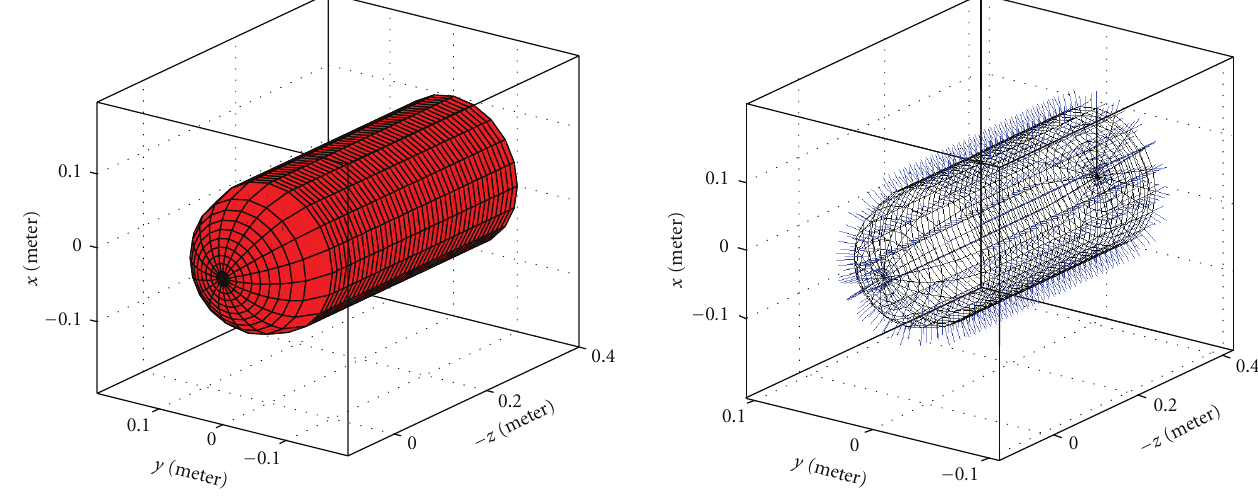
Figure 2: Computer-generated three-dimensional model of the shell-shaped projectile.